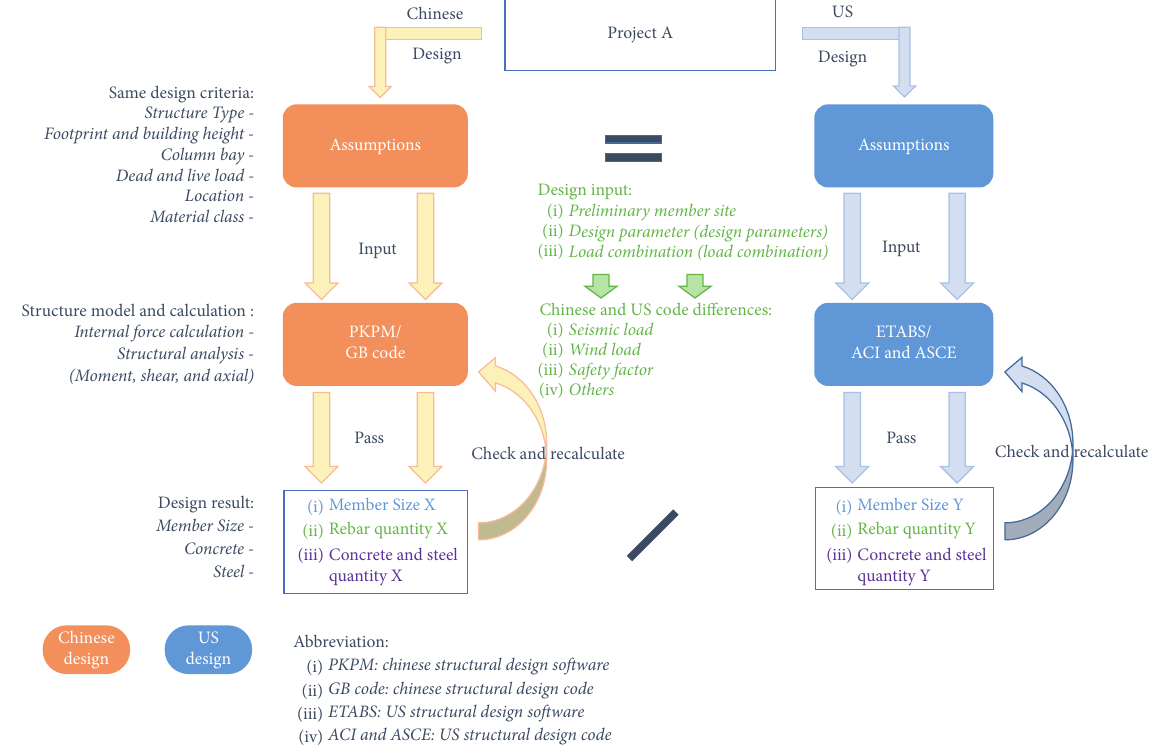
Figure 3: Structural design comparison model.